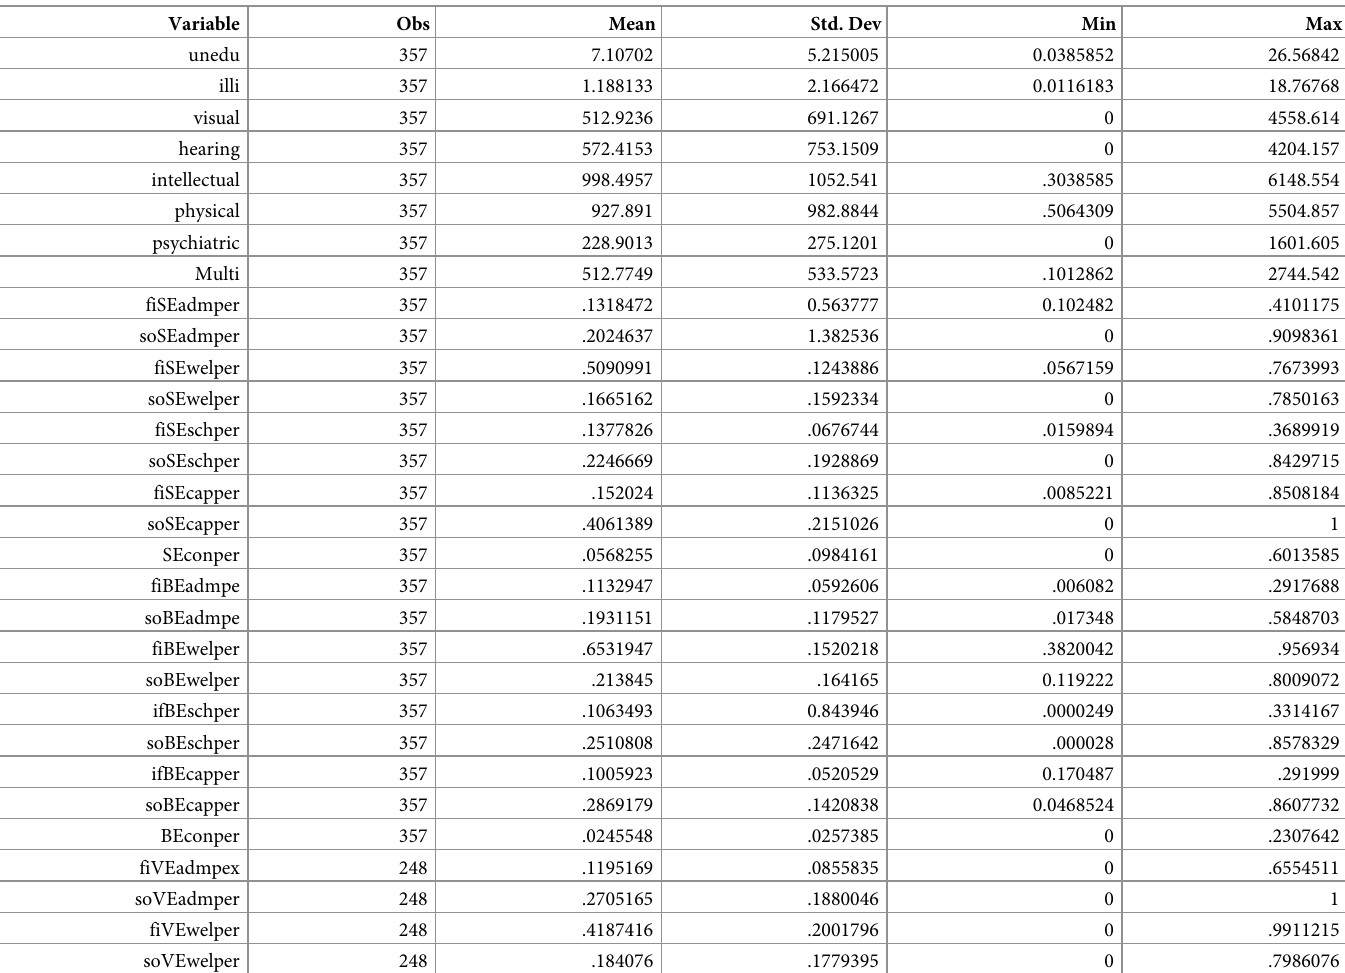
Table 2. The statistic description of all